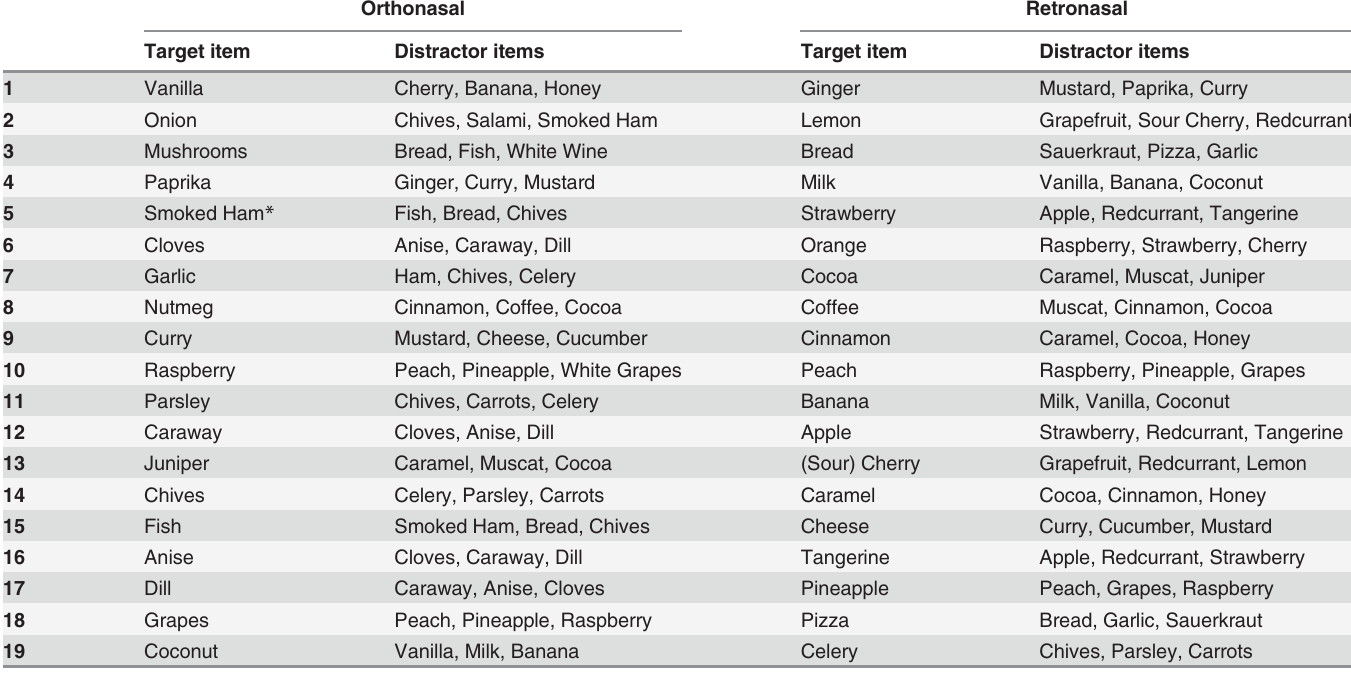
Table 2. Orthonasal and retronasal